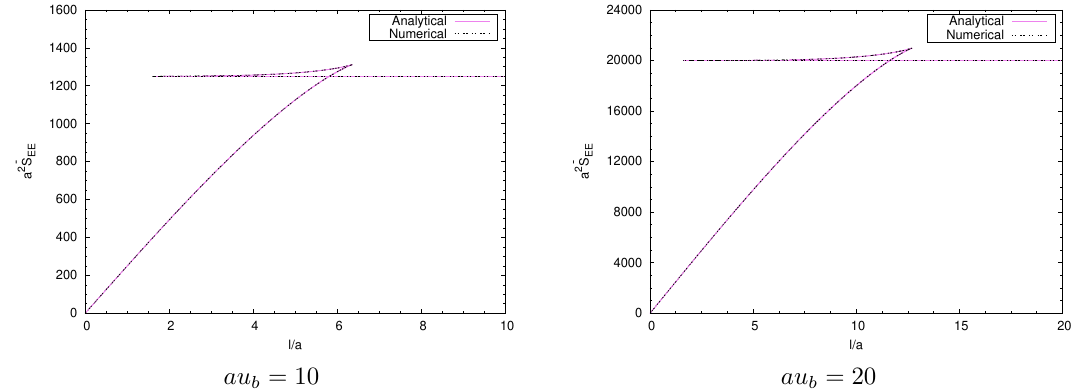
Figure 2 . Variation of a 2 ¯ S EE with respect to l ( au b = 10 , 20